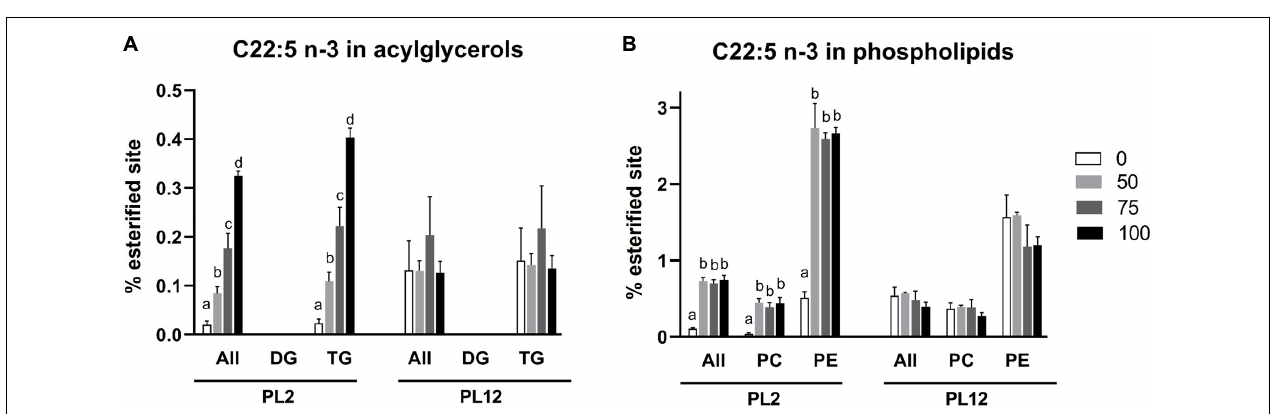
FIGURE 7 | Analysis of the 22:5 n-3 fatty acid distribution in lipid classes and subclasses by LC-HRMS. Percent of meal replacement was the percent of meals for which TW was replaced by AL. Percent esterified site is the percent of sites esterified with 16:0 compared with all the sites esterified with any types of fatty acids on the backbone. Error bars represent standard errors ( N = 3). Statistical analyses of the PL2 and PL12 data sets were performed separately, using ANOVA. Significant differences among subsets of treatment groups were determined by Duncan’s multiple range test ( P < 0.05); subsets with means not significantly different from one another are identified with the same letter above the bar. Bars with no specified letters mean no significant differences were identified among the groups ( P > 0.05).